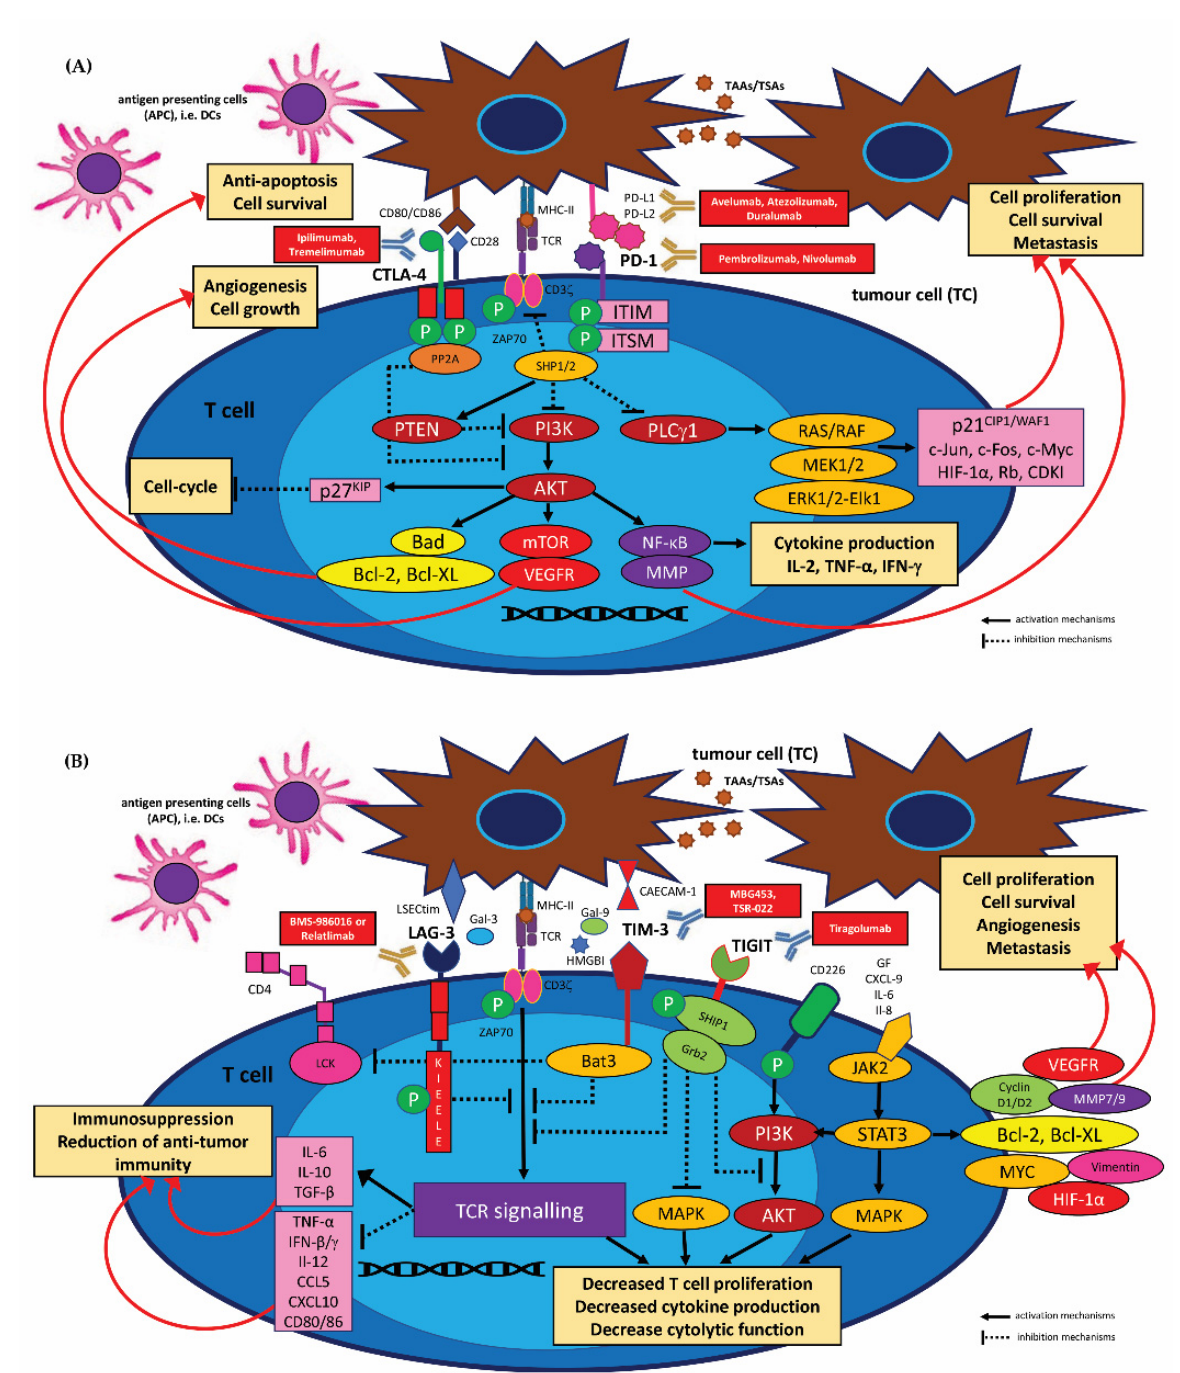
Figure 3. Intracellular immune checkpoint receptor signalling and functional effects of their activity in HNSCC. ( A ) PD-1 and CTLA-4 target different molecules to inhibit T cell activity by inhibiting PI3K/AKT signalling. PD-1 ligation by PD-L1 or PD-L2 on tumour cells (TCs) leads to phosphory- lation of ITSM/ITIM motifs in T cells, which recruits the tyrosine phosphatases SHP1 and SHP2 to inhibit TCR ζ -induced activation of the PI3K/AKT and to activate PTEN , a protein coding gene. This lowers Bad, Bcl-2 and Bcl-xL expression, downregulates mTOR/VEGFR signalling and suppresses transcription, resulting in the accumulation of p27 KIP1 and inhibition of cyclin-dependent kinases (CDKI); this blocks cell cycling and proliferation. PD-1 ligation also inhibits PLC γ 1 and the down- stream Ras/Raf/MEK1/2/ERK1/2 pathway leading to the upregulation of the pro-apoptotic mecha- nisms. CTLA-4 engagement by its ligands CD80/CD86 on TCs activates the serine/threonine